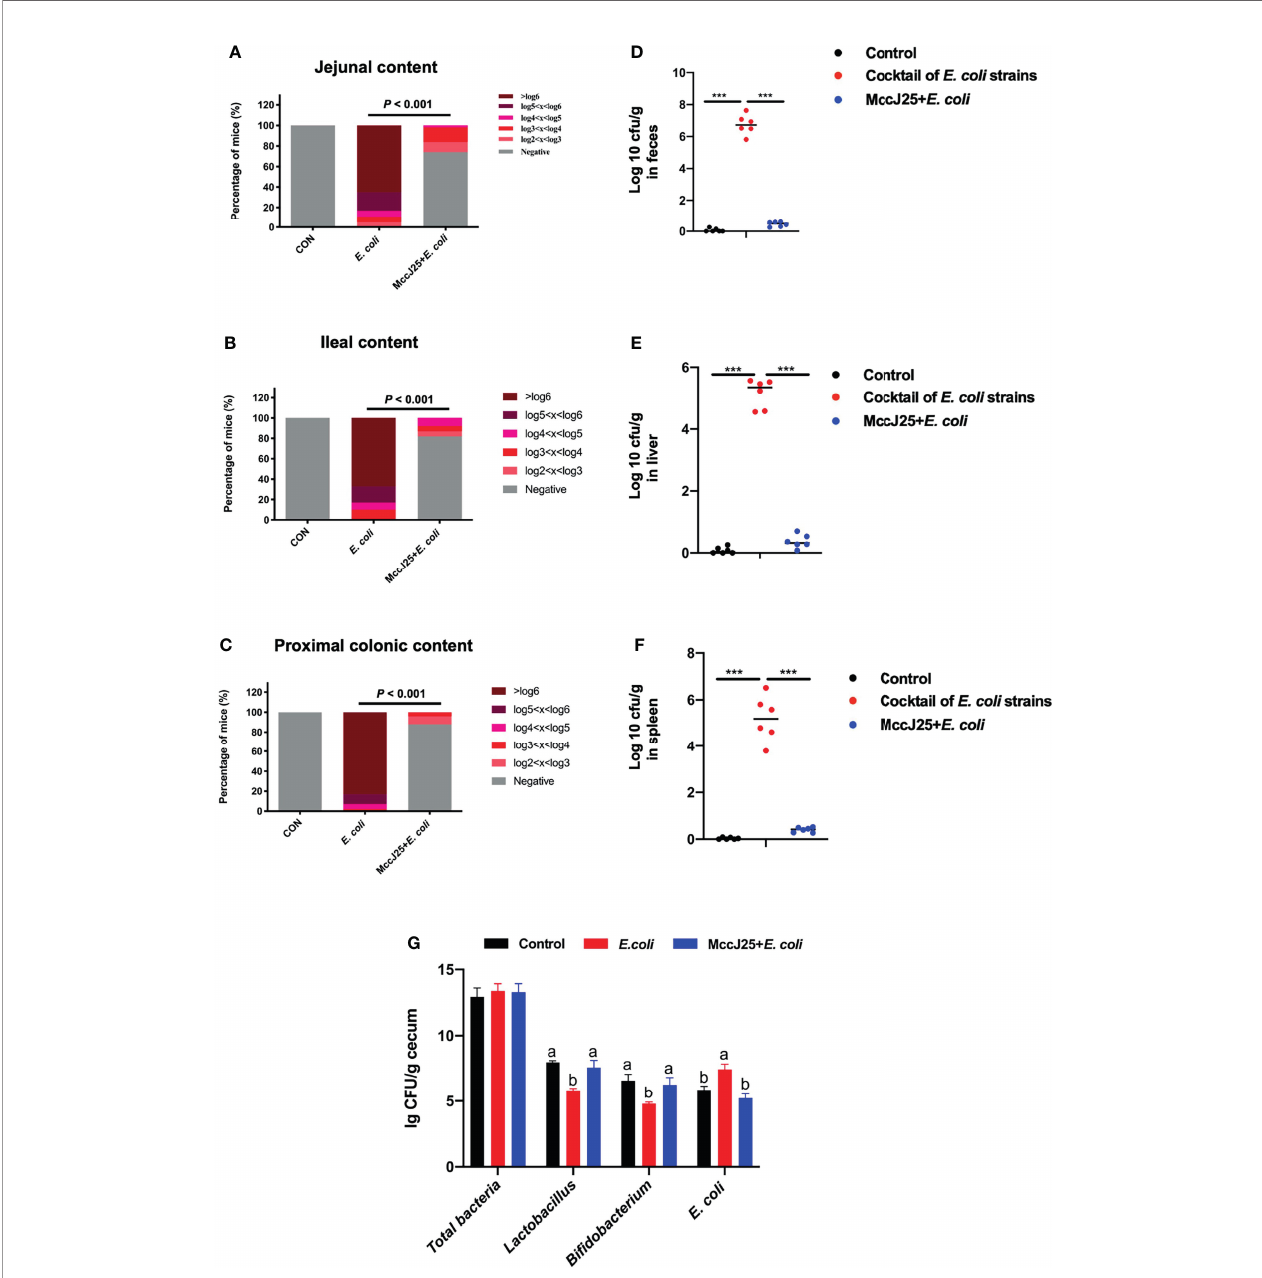
FIGURE 11 | Protective capacity of MccJ25 on the enhancement of host against colonization and invasion of MDR E coli strains. Colonization of MDR E coli strains in contents of jejunum (A) , ileum (B) , and proximal colon (C) . The nonparametric Mann-Whitney test was used to look for differences in fecal shedding and organ colonization between the infected and MccJ25 groups. The Chi-Square test (likelihood ratio) was performed to examine the frequency of positive animals in various E coli levels in intestinal segments. (D) Bacterial load in feces. Evaluation of the shedding number of E coli in fecal from mice of different treatment group (n = 6) after infection. Assessment of invasion of MDR E coli strains in systemic organs including liver (E) , spleen (F) , and copy numbers of target bacteria in cecum (G) were determined at d 3 after infection (n = 6). Assay was performed by counting the bacterial colony using culture-based assay. Results are presented as the mean ± standard error of mean. Signi fi cant differences were tested using a one-way ANOVA followed by a Tukey ’ s multiple range test. *** P < 0.001. Different superscript lowercase letters within each group indicate signi fi cant differences ( P <